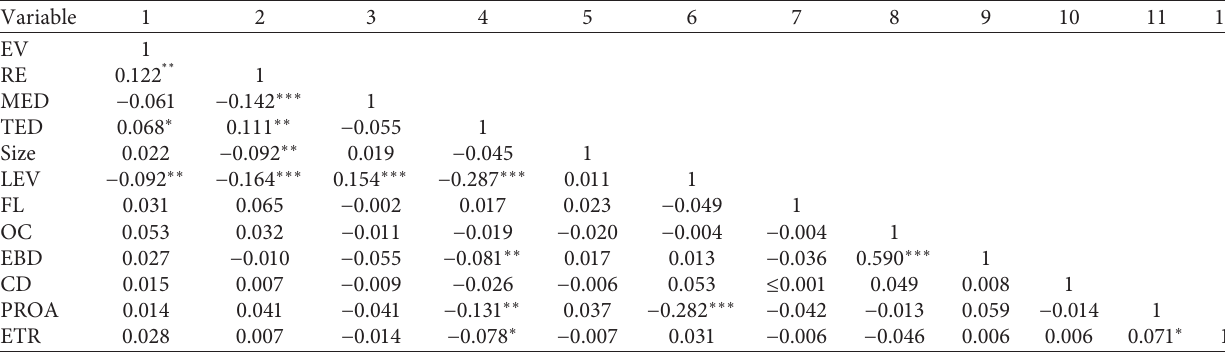
Table 3: Correlation analysis of each